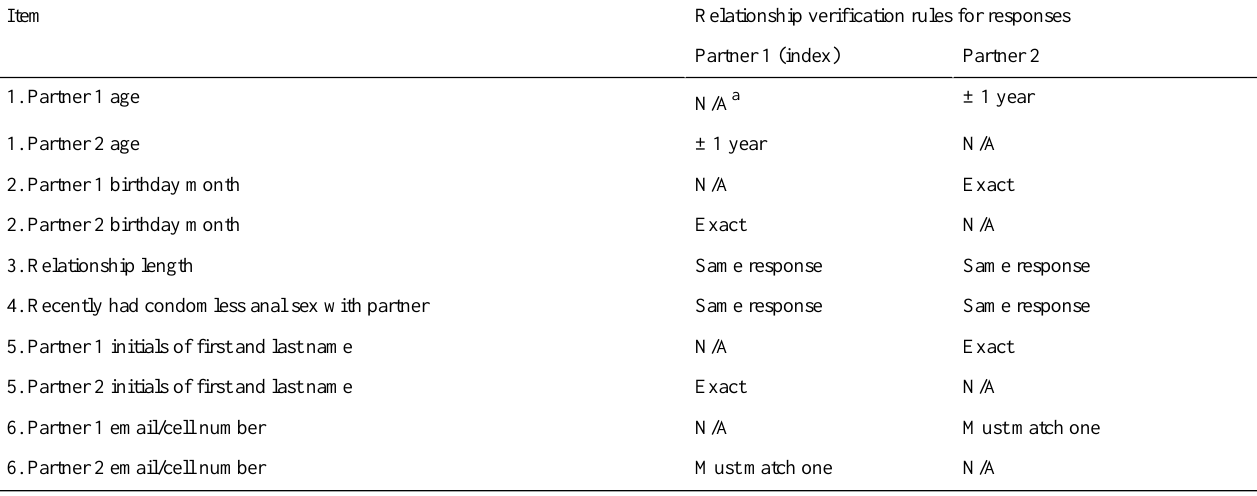
Table 1. Screener items with accompanying decision rules used for couple verification